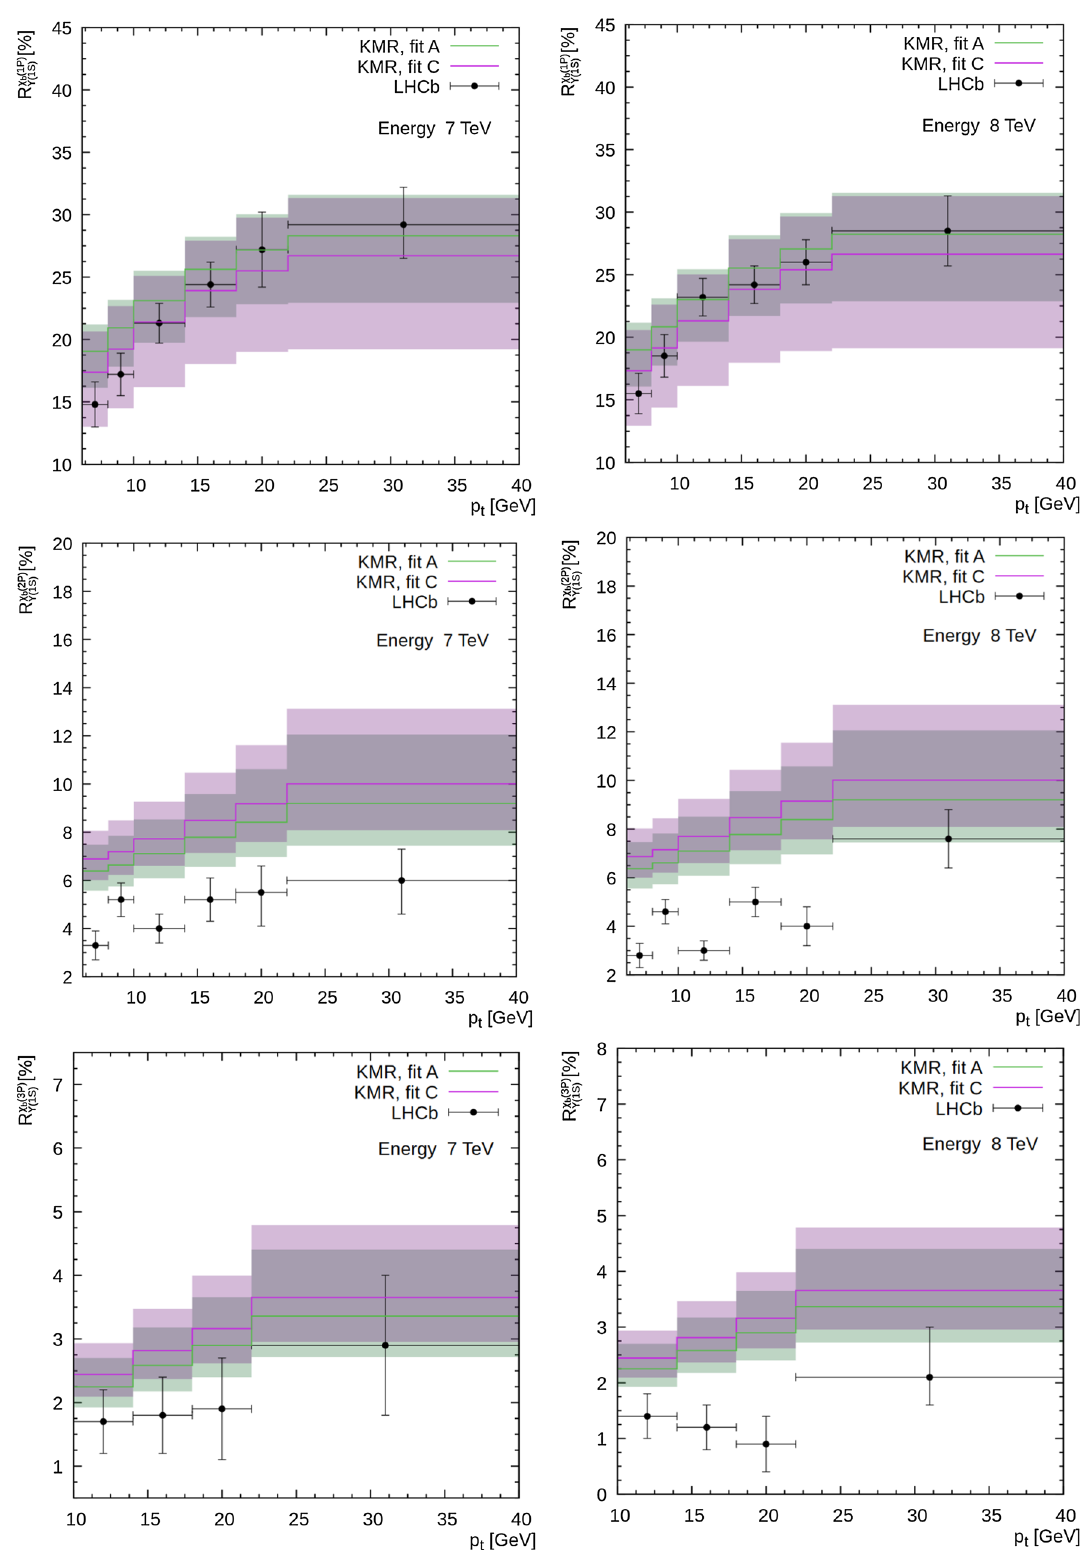
√ s = 7 and 8 TeV. The notation of all